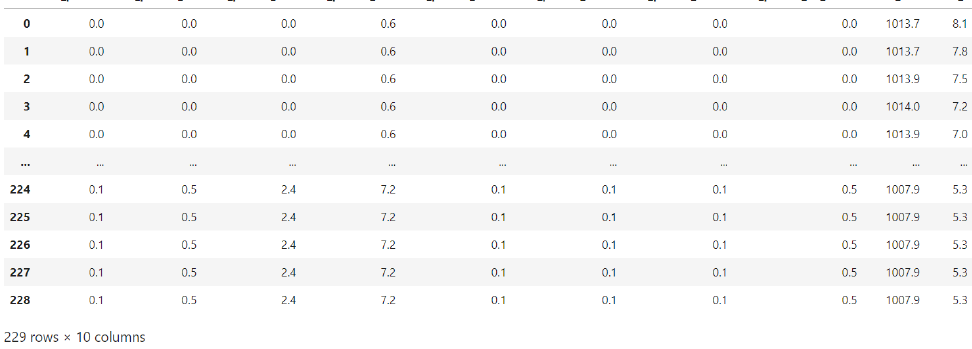
Figure 3. Derived weather parameters from SMHI. The same set of parameters are also generated from local IoT sensors as estimation of SMHI’s history